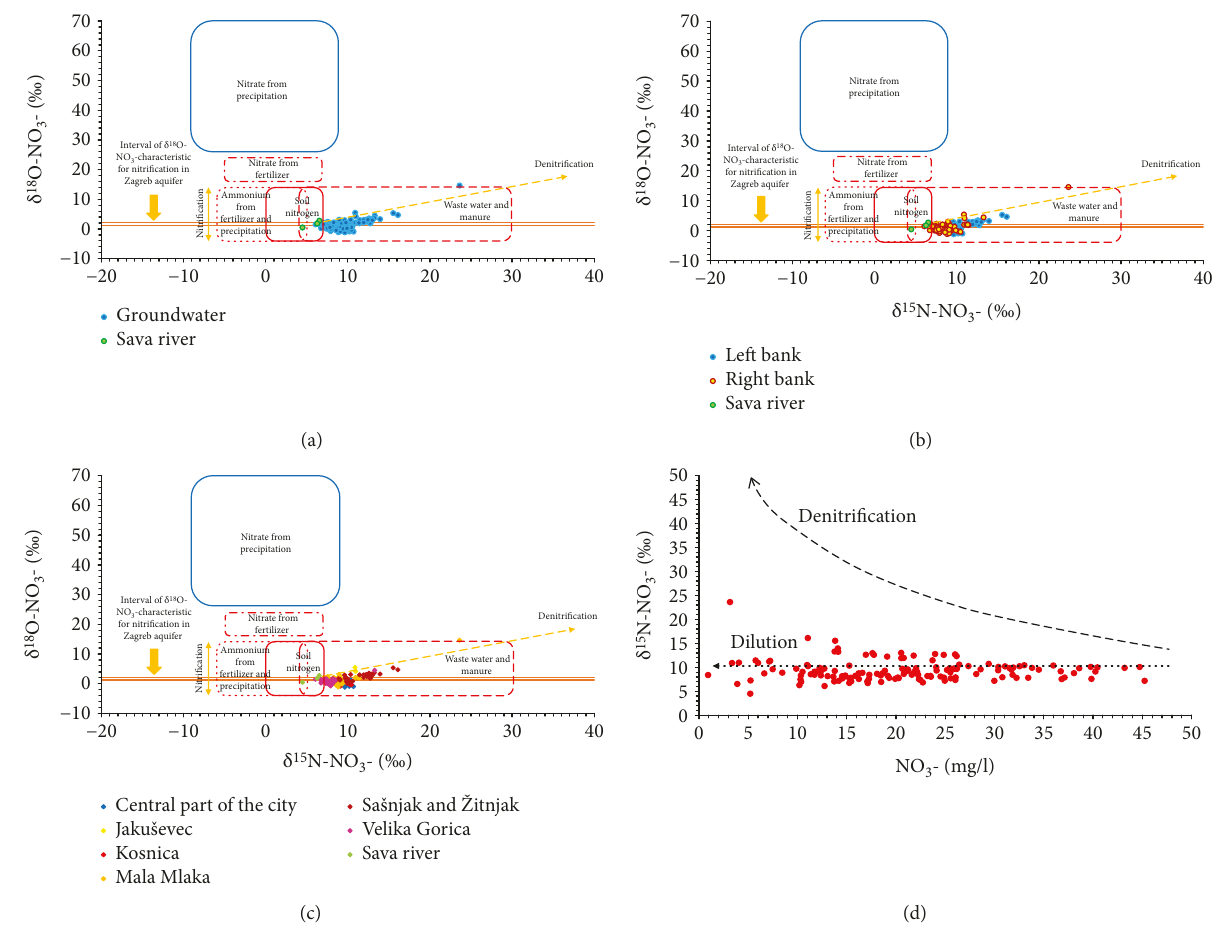
Figure 5: Values of nitrate stable isotope composition: (a) at the level of the whole Zagreb aquifer; (b) at the level of the left and right Sava River banks; (c) at the level of the spatially grouped observation wells; (d) evaluation of the process of denitri fi